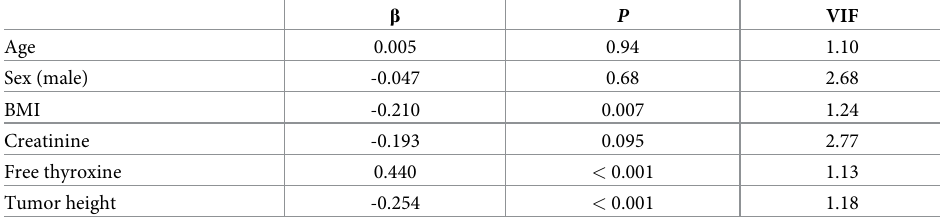
Table 2. Multiple regression analyses with peak GH response to GHRP-2.